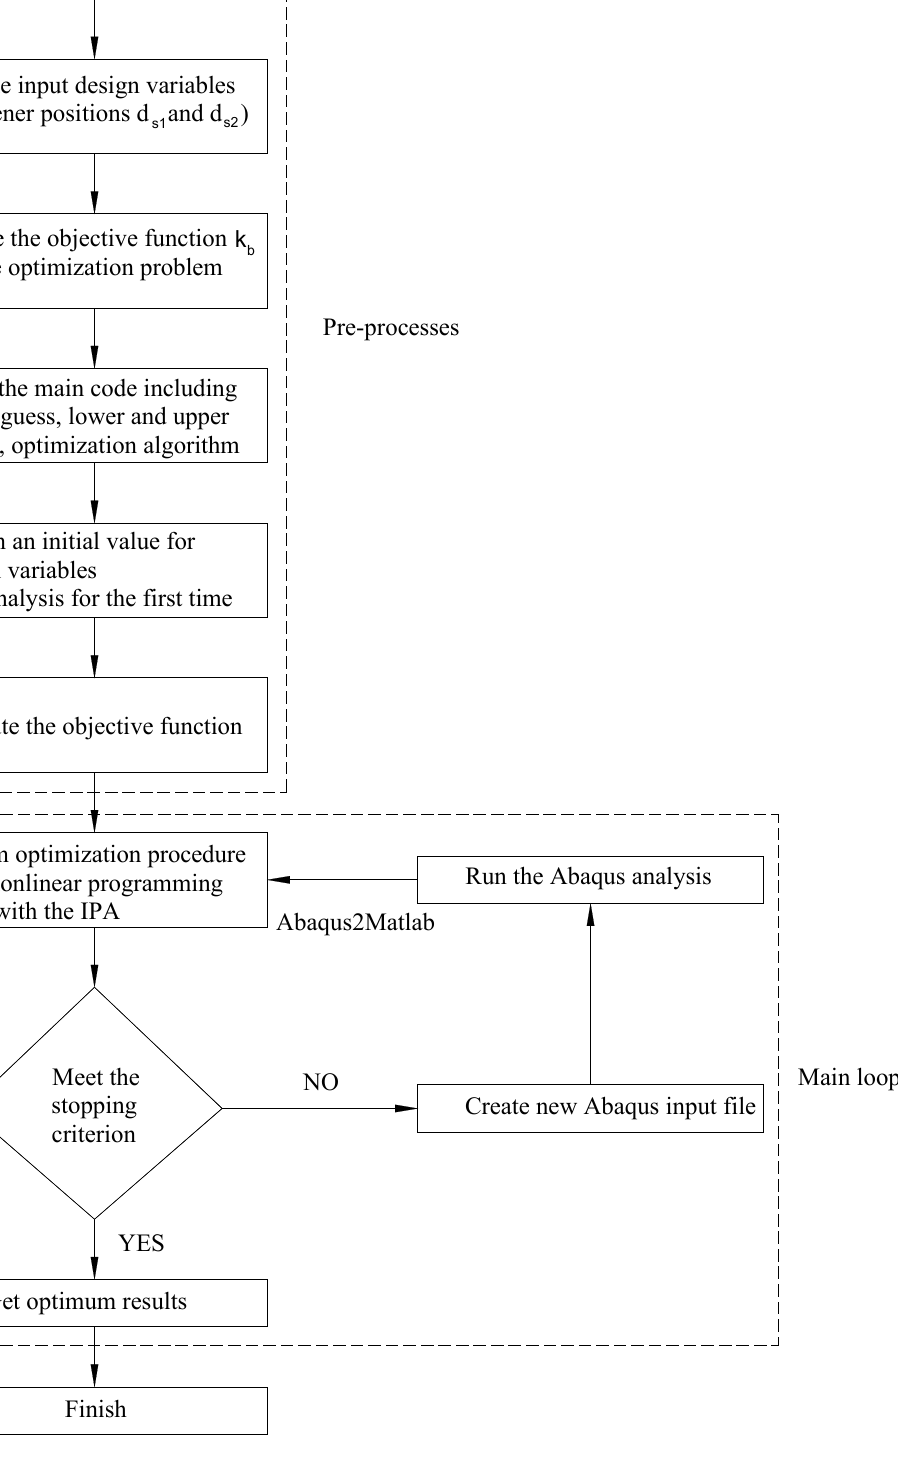
Figure 1. The optimization procedure flowchart [10,11].